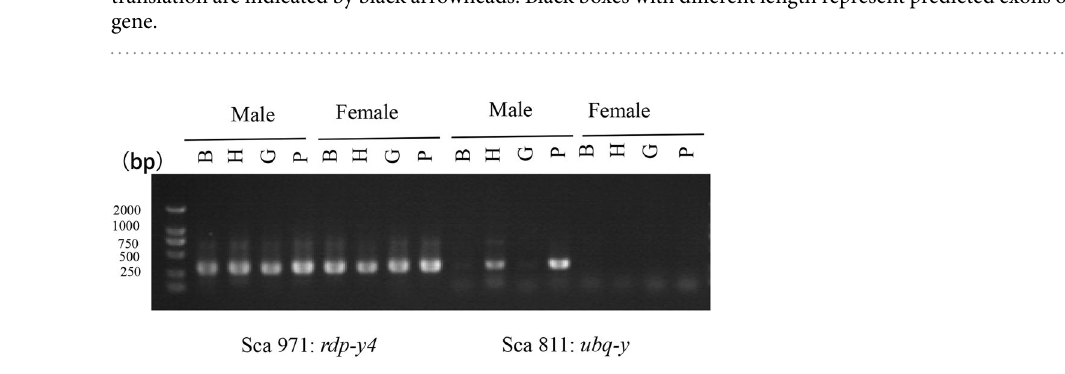
Figure 6. Expression of two Y-linked genes ( rdp-y4, ubq-y ) in females and males. Template cDNAs were derived from four tissues (B: brain, H: hypothalamus, G: gonad, and P: pituitary). Each tissue was extracted from three adult male/female individuals. rdp-y4 gene was amplified in all four tissues in both sexes with high abundance, thereby confirming the quality of the cDNA templates. ubq-y was not detected in the female tissues and was highly expressed in two male tissues (hypothalamus and